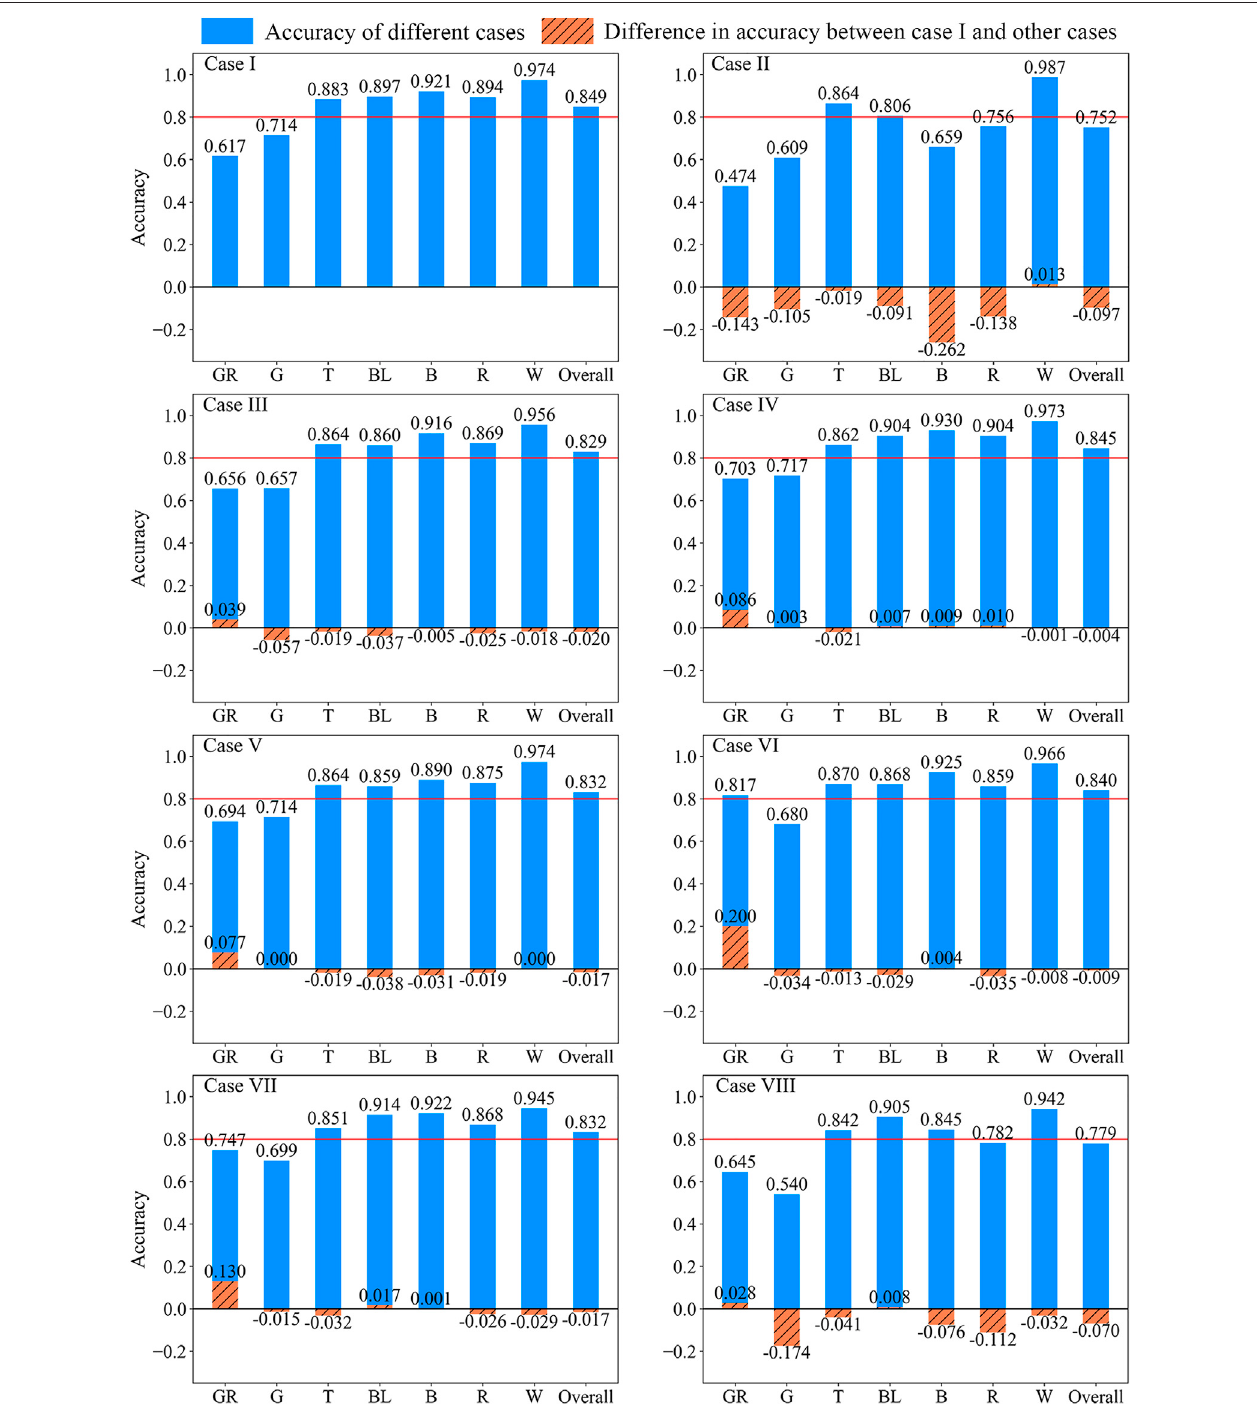
FIGURE 9 | Accuracies of classi fi cation results with different image layers. The abbreviations for the classes on the abscissa are as follows: GR. green roofs, G. grass, T. trees (shrubs), BL. bare land, B. buildings, R. roads, W. water.